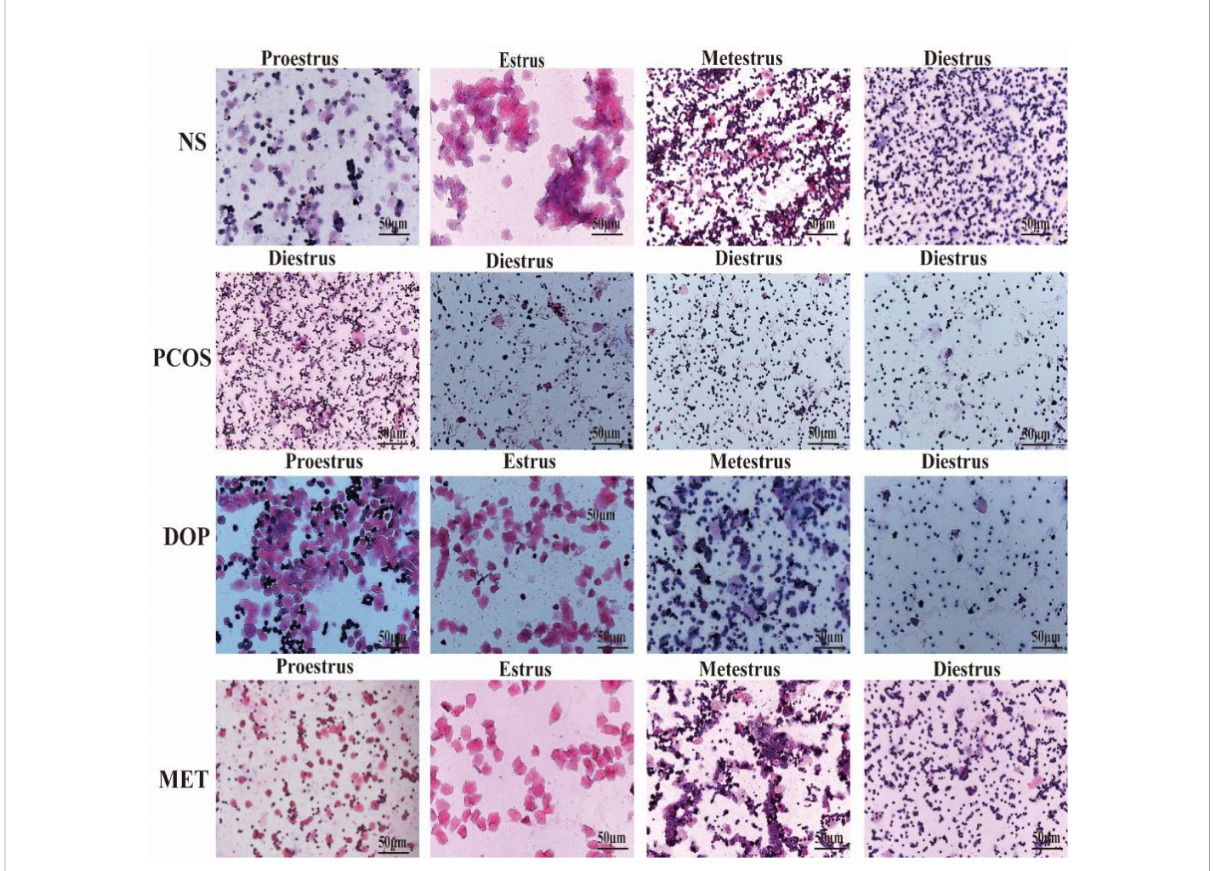
FIGURE 2-1 Vaginal smear identi fi cation of estrus stage in rats (H&E) . Note: scale bar = 50 m